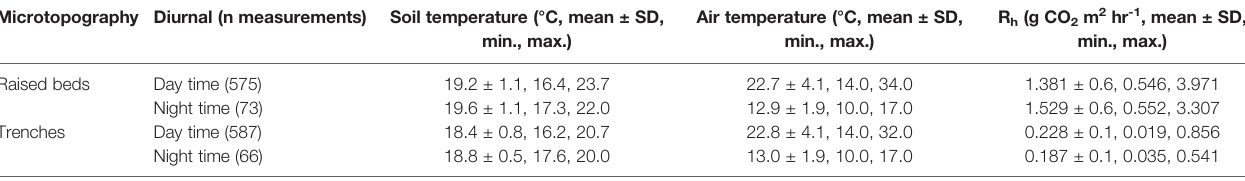
Air temperature (°C, mean ± SD, min., max.) min.,